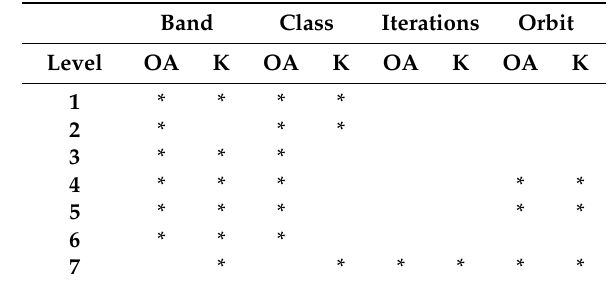
Table 6. Results of the variance analyses performed by level (OA and k as numerical variables in every case). The asterisk (*) implies significant results with p -value <